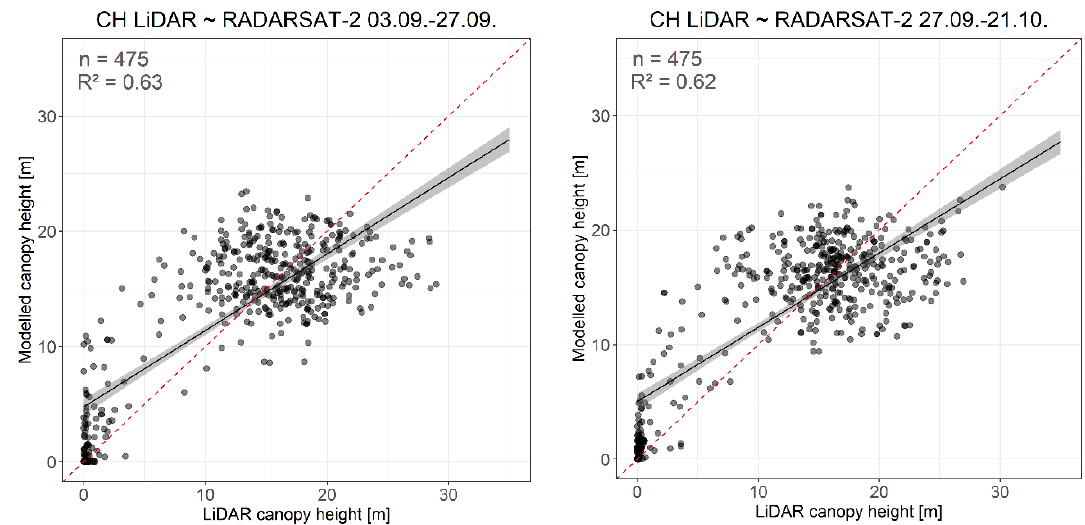
Figure 5. Correlation of reference LiDAR canopy height and modelled RS-2 canopy height using RMoG model based on an interferogram from 03.09.–27.09. (left) and 27.09.–21.10. (right). Red dashed line = 1:1 line; black line = linear trend including confidence bounds.